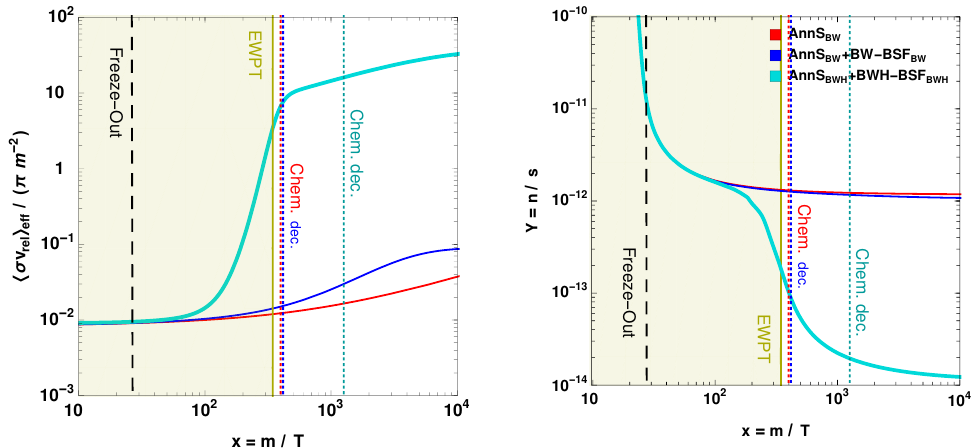
Figure 4 . The effective cross-section h σv rel i eff / ( πm − 2 ) and the dark matter yield Y ≡ n/s , vs. the time parameter x = m/T . We also mark the time of freeze-out, the EWPT, and the chemical decoupling for the three cases in the legend. We have used m = 50 TeV and α